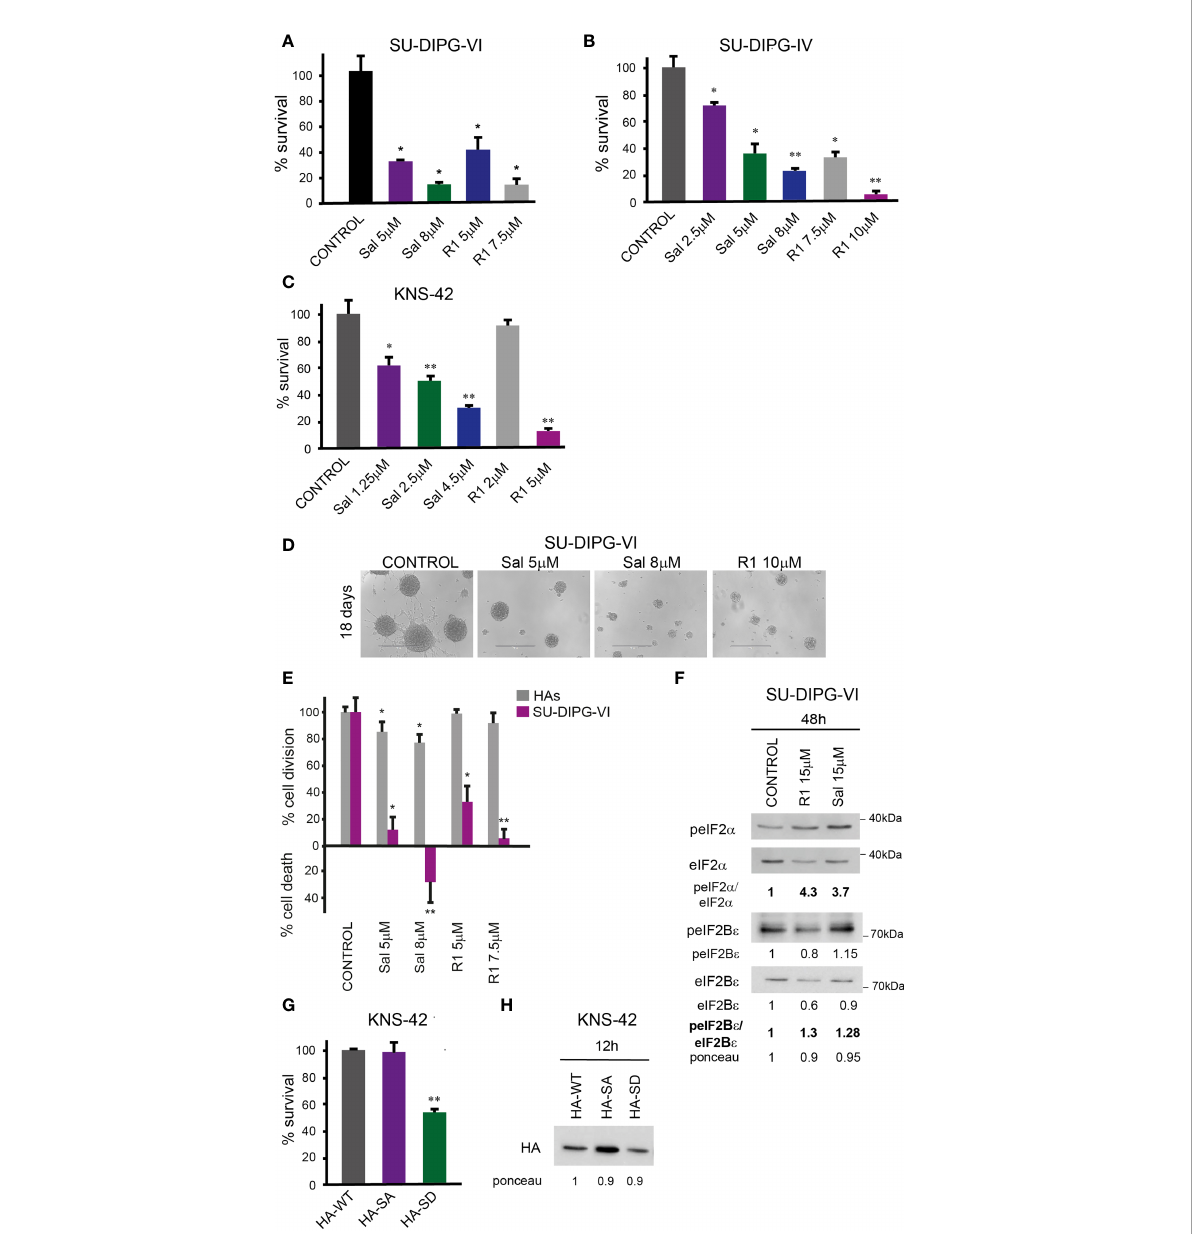
FIGURE 3 Salubrinal and raphin-1, as well as S51D-eIF2 a , decreased cell survival and affected the eIF2B e level and phosphorylation: (A, B) . SU-DIPG-VI and SU-DIPG-IV cells were plated in triplicates at a density of 11,550 or 3,300 cells/cm 2 , respectively, and treated 24 h post-plating. (C) . KNS-42 cells were plated in triplicates for clonogenic survival assay and treated 24 h post-plating. Values (A – C) are mean survival (%) ± S.D relative to control. Differences among all experimental groups, as well as between each experimental group and control, were signi fi cant — *p< 0.5, **p< 0.005. (D) . A representative image of SU-DIPG-VI neurospheres 18 days post-treatment with salubrinal and raphin-1. Bar, 400 m m. (E) . SU-DIPG VI and HAs cells were plated in triplicates at the same density (3,300 cells/cm 2 ) and treated 24 h post-plating. Values are mean number of cell division or cell death (%) ± S.D relative to control. Differences between treated and untreated experimental groups, as well as between SU- DIPG-VI and HAs, were signi fi cant — *p< 0.05, **p< 0.005. (F) . SU-DIPG-VI cells were processed for Western blot analysis of treatment-induced changes in the ratios of peIF2 a /eIF2 a and peIF2B e /eIF2B e and in the cellular level of eIF2B e . Numbers at the bottom of the autoradiograms indicate changes of peIF2 a /eIF2 a , peIF2B e /eIF2B e , and eIF2B e and differences in loaded proteins (Ponceau) relative to control. (G) . KNS-42 cells were plated in duplicates at a density of 13,200 cells/cm 2 and transiently transfected with 1 m g/ml of plasmids expressing HA-eIF2 a (HA-WT) or HA-S51A-eIF2 a (HA-SA) or with HA-S51D-eIF2 a (HA-SD) 24 h post-plating. Values are mean survival (%) ± S.D relative to control. Differences between survival of HA-SD to the HA-WT and HA-SA were signi fi cant — **p< 0.005. (H) . Cells were transiently transfected as described in G and 12 h later processed for Western blot analysis of HA-tag expression. Numbers at the bottom of the autoradiograms indicate differences in loaded proteins (Ponceau) relative to HA-WT. Sal — salubrinal, R1 — raphin-1. The experiments were reproduced at least twice with similar